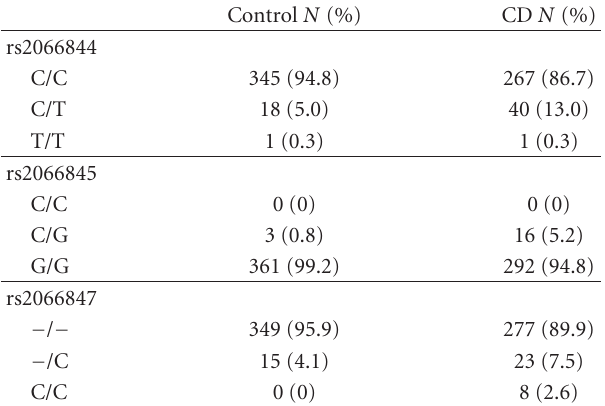
Table 6: Frequency of NOD2 genotypes in the study